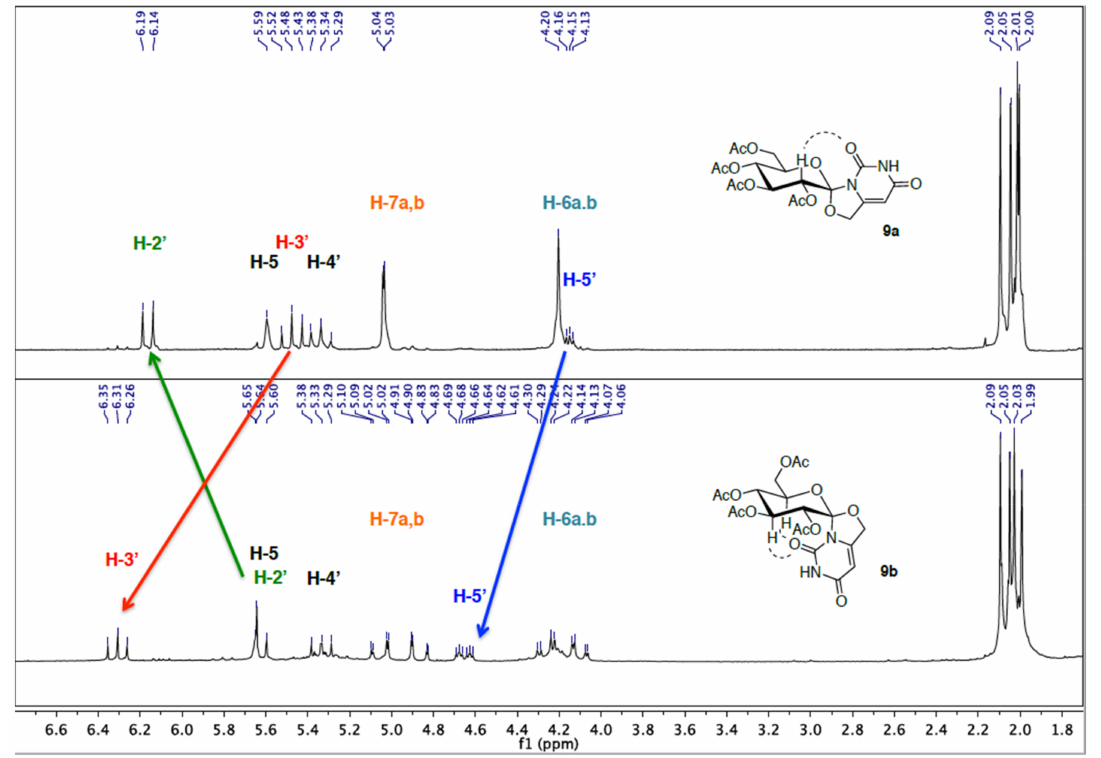
Figure 2. Comparison of 1 H-NMR spectral shifts in compounds 9a , b